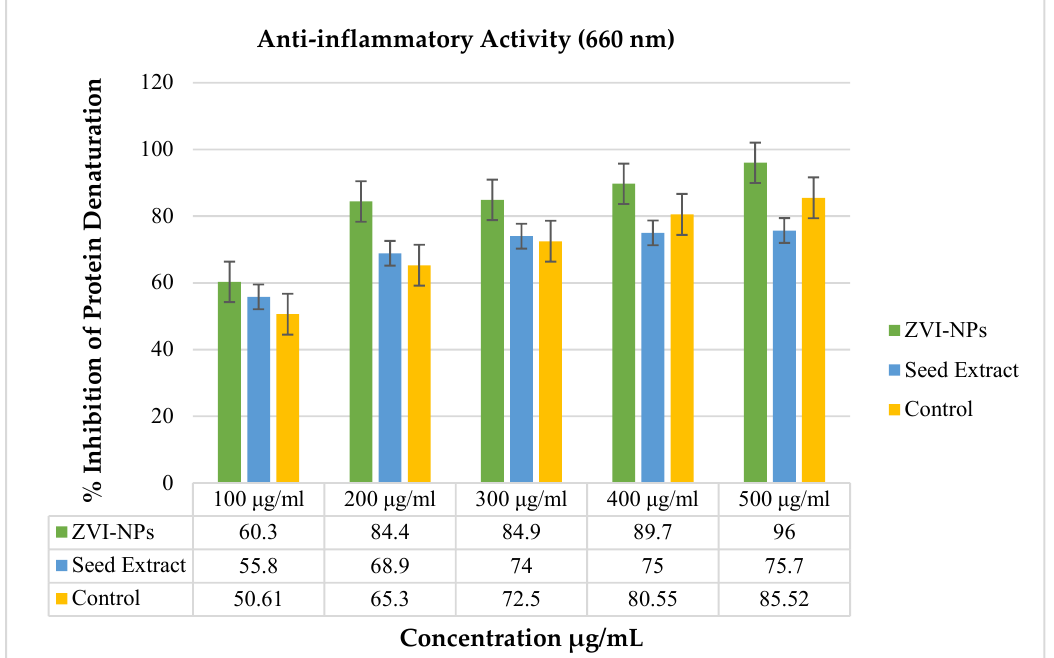
Figure 8. Graphical presentation of % inhibition of protein denaturation at specific concentrations of control (aspirin), seed extract, and ZVI-NPs, thus showing 96% anti-inflammatory activity by ZVI-NPs at 500 µ g/mL.